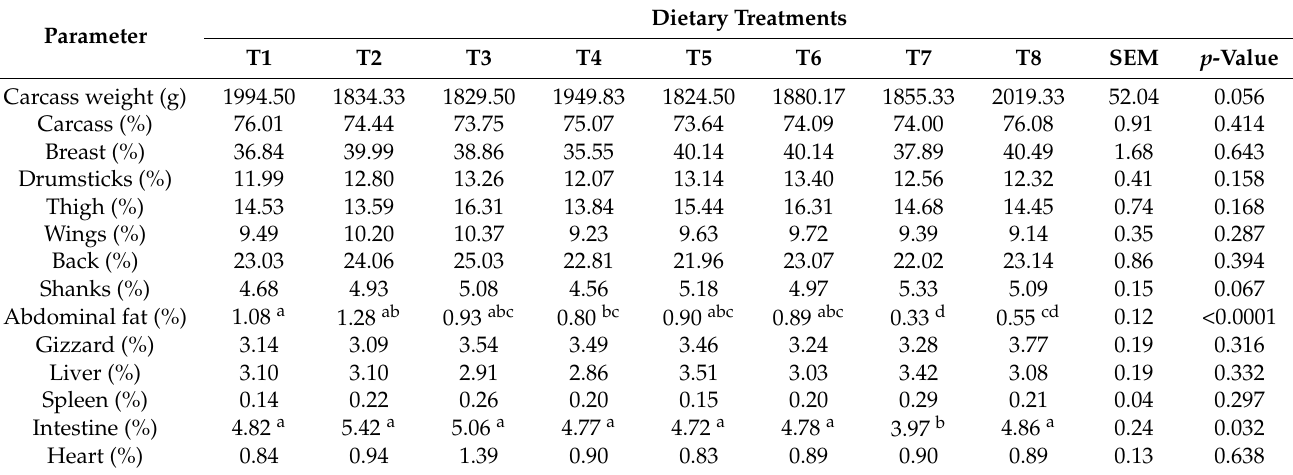
Table 5. Carcass weight and carcass yield of broiler chicken fed different strains of L. plantarum postbiotic and paraprobiotic.